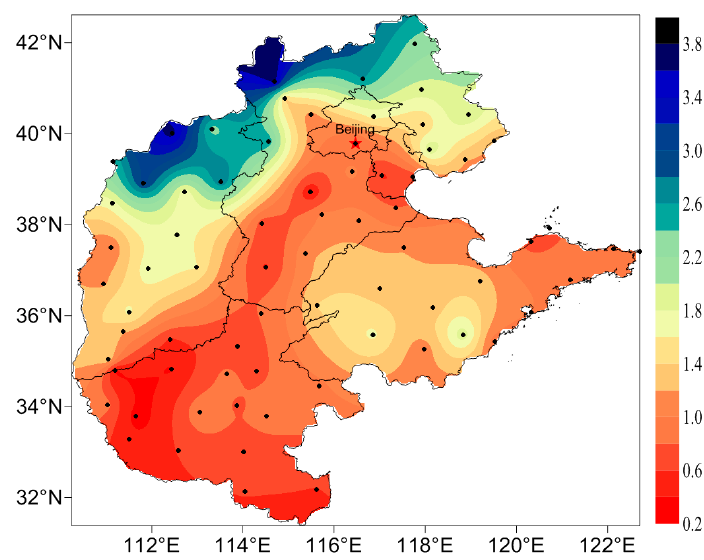
Figure 3. The climatological mean frequency of autumn cold surges in 72 stations of North China from 1961 to 2014 (black dots indicate the stations).